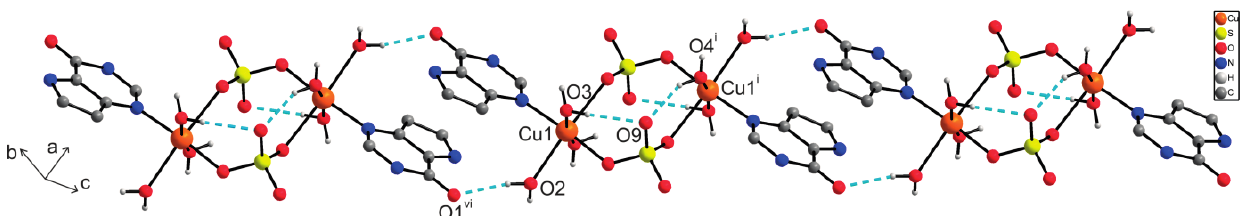
Figure 1. The molecular structure of [{Cu(9dhx)(H 2 O) 3 } 2 (µ-SO 4 ) 2 ] ( 1 ), showing the atom numbering scheme. Non-hydrogen atoms are displayed as ellipsoids at the 50% probability level. Symmetry code: (i) − x + 2, − y, − z + 2.